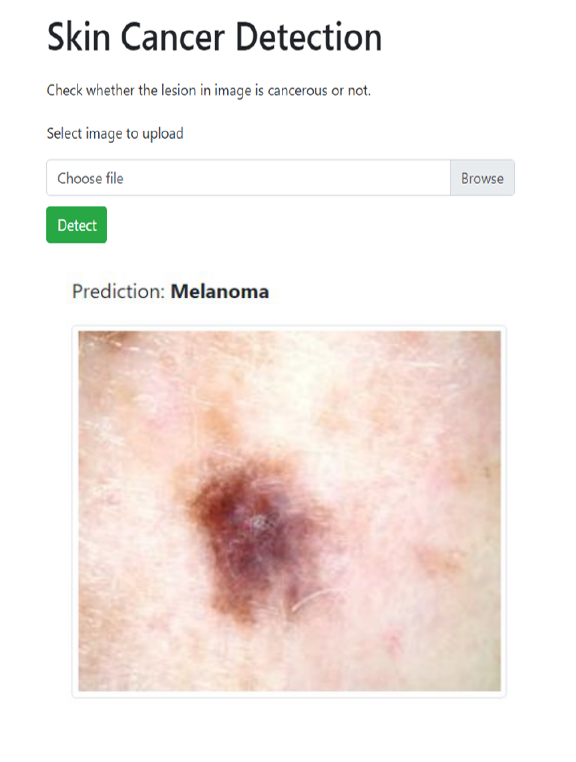
Figure 4.5: The predicted skin cancer